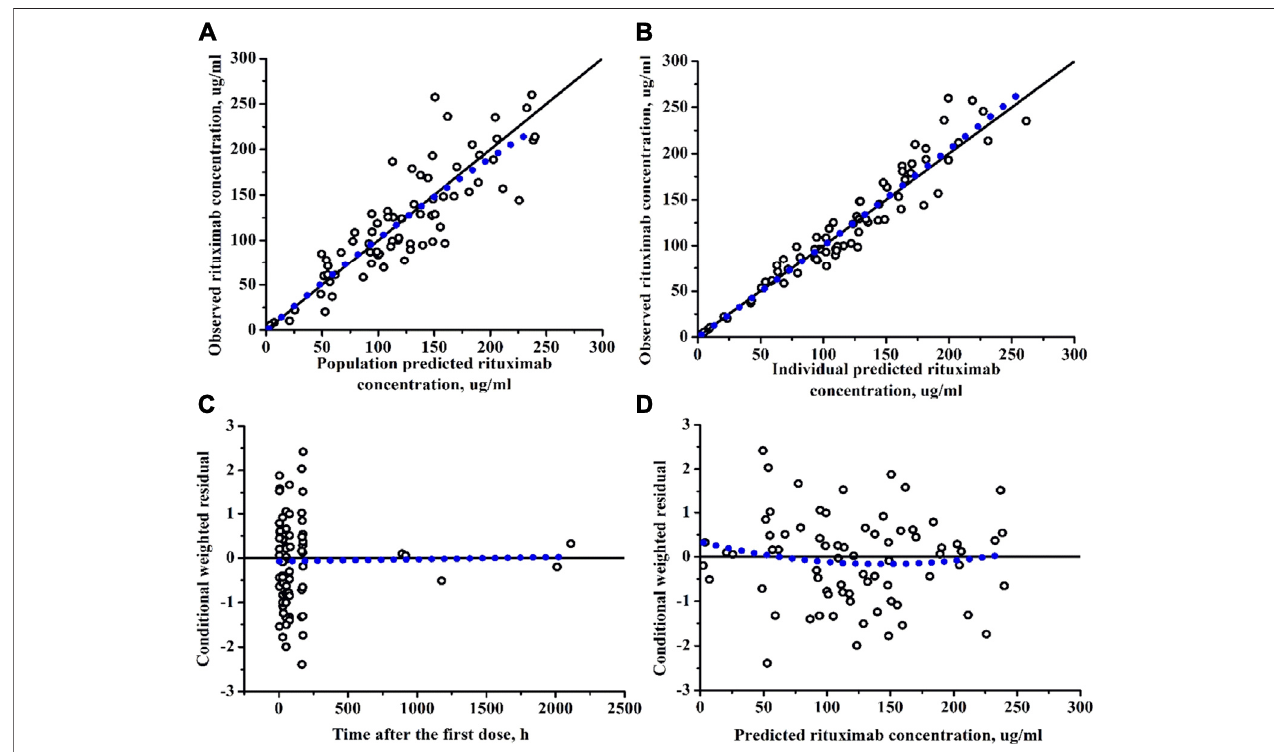
FIGURE 2 | Diagnostic plots of rituximab fi nal PK model. (A) The observed versus population-predicted concentration. (B) The observed versus individual- predicted concentration. (C) Conditional weighted residual versus time. (D) Conditional weighted residual versus the predicted concentration.